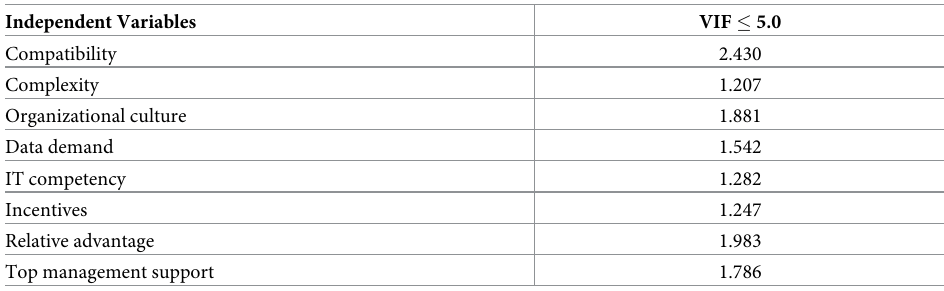
Table 8. Results for lateral collinearity